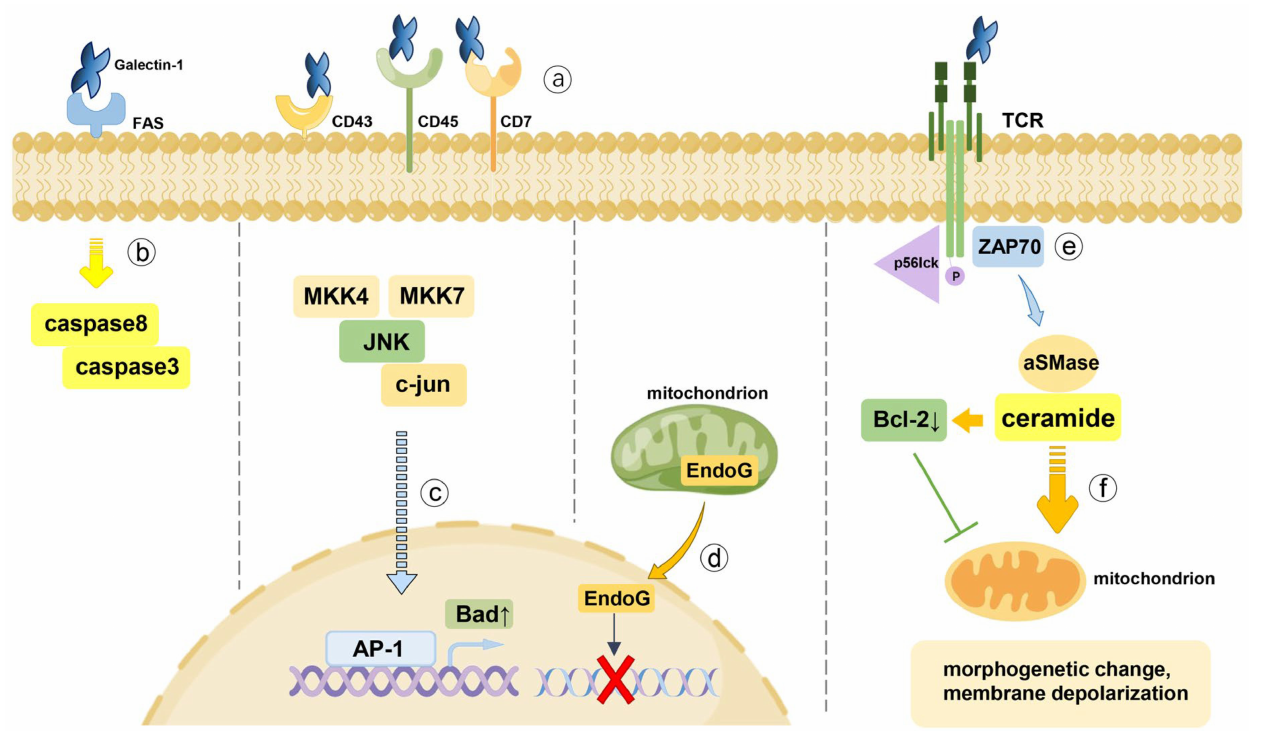
Figure 2. The mechanisms of T cell apoptosis induced by galectin-1. (a) Galectin-1 binding to CD7, CD43, and CD45 is a crucial step to mediate T cell apoptosis. (b) Fas (CD95) was proved to